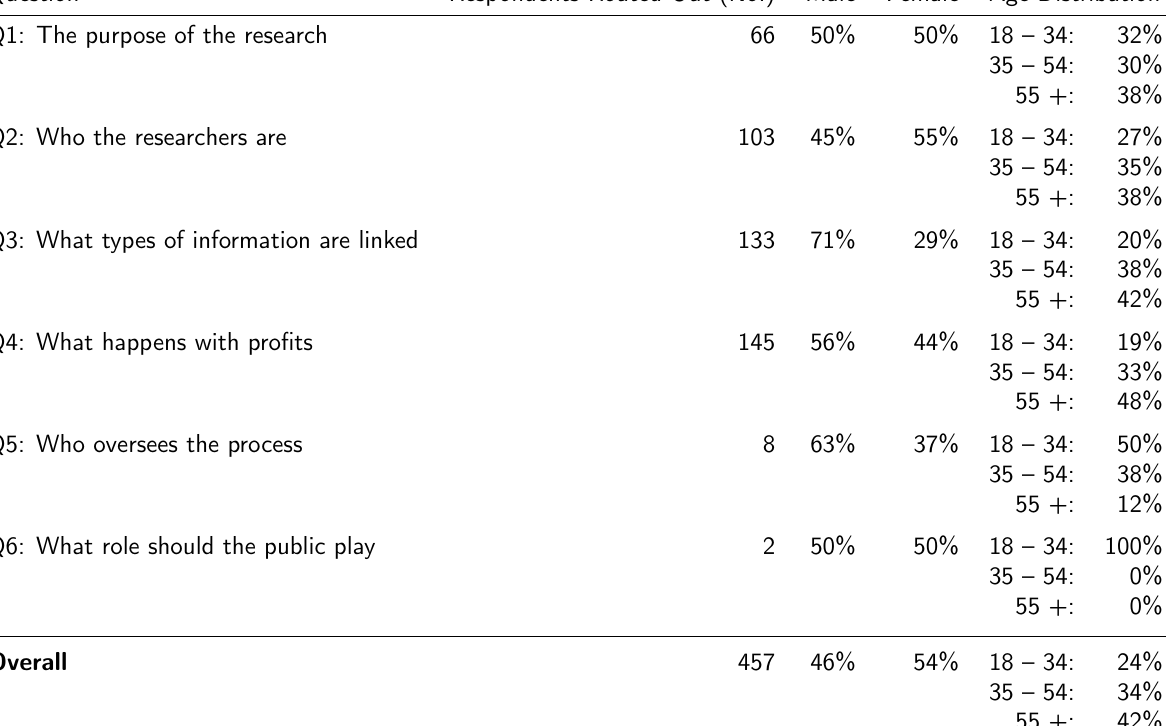
Table 4: Respondents routed out of questionnaire